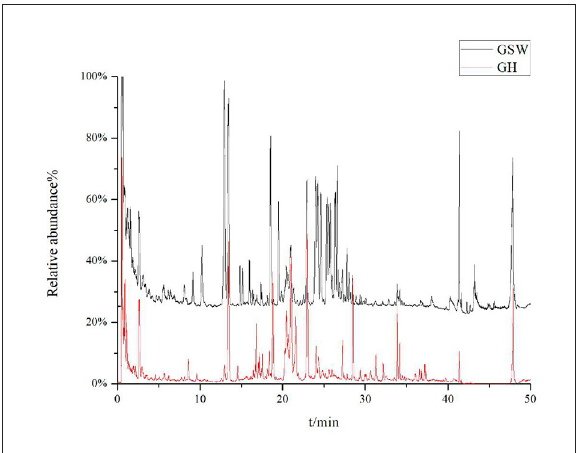
FIGURE1 Representative UPLC-Q-Orbitrap-HRMS total ion chromatograph of ginseng Huang jiu and ginseng-soaked Wine.